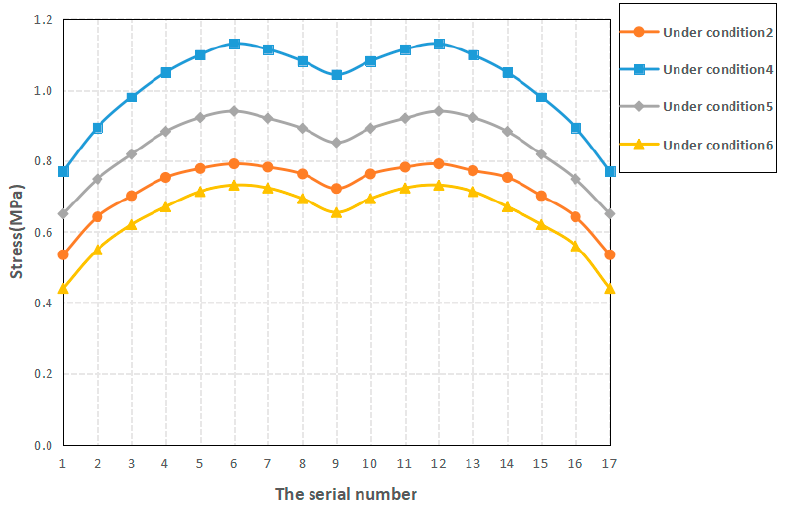
Figure 7. Stress profiles under four working conditions (working condition 2 and working condi- tions 4 to